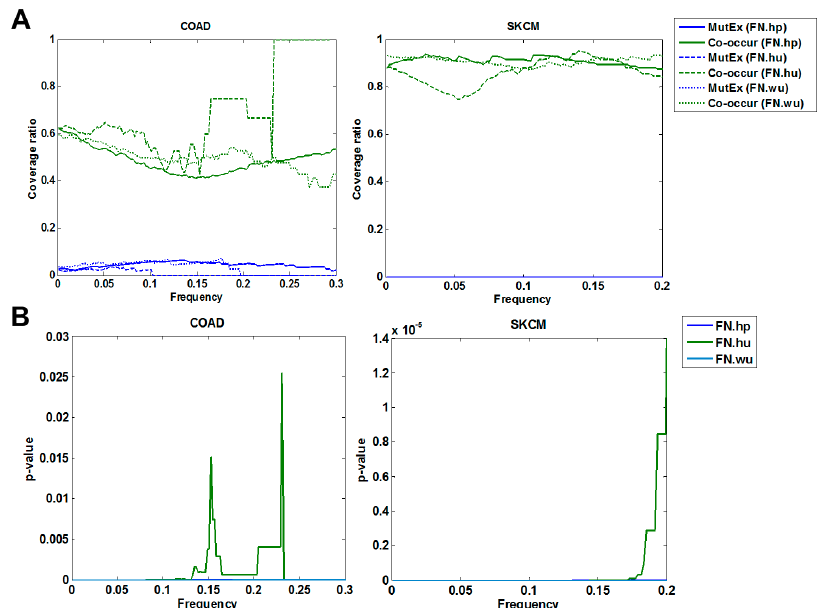
Figure 2. Co-occurrence and mutual exclusivity analysis of fitness relationships. ( A ) The variation of edges of co-occurrence (co-occur) and mutually exclusivity (MutEx) with frequency cutoffs in FNs. ( B ) Significance of co-occurring edges with frequency cutoffs in FNs.